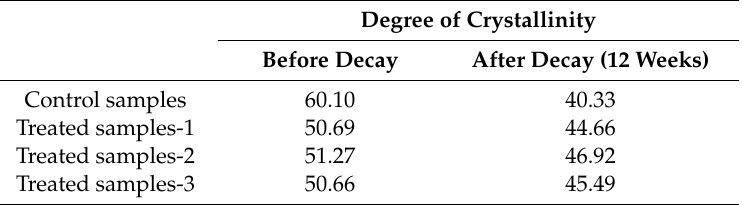
Table 3. Crystallinities of wood samples before/after decay.